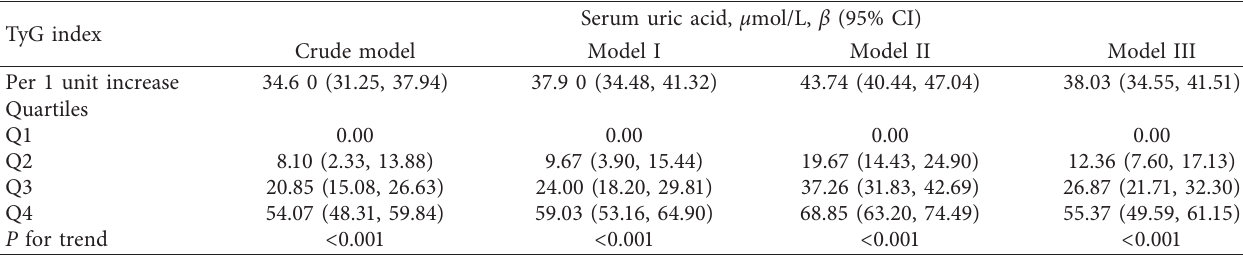
Table 2: Association between the TyG index and SUA in different